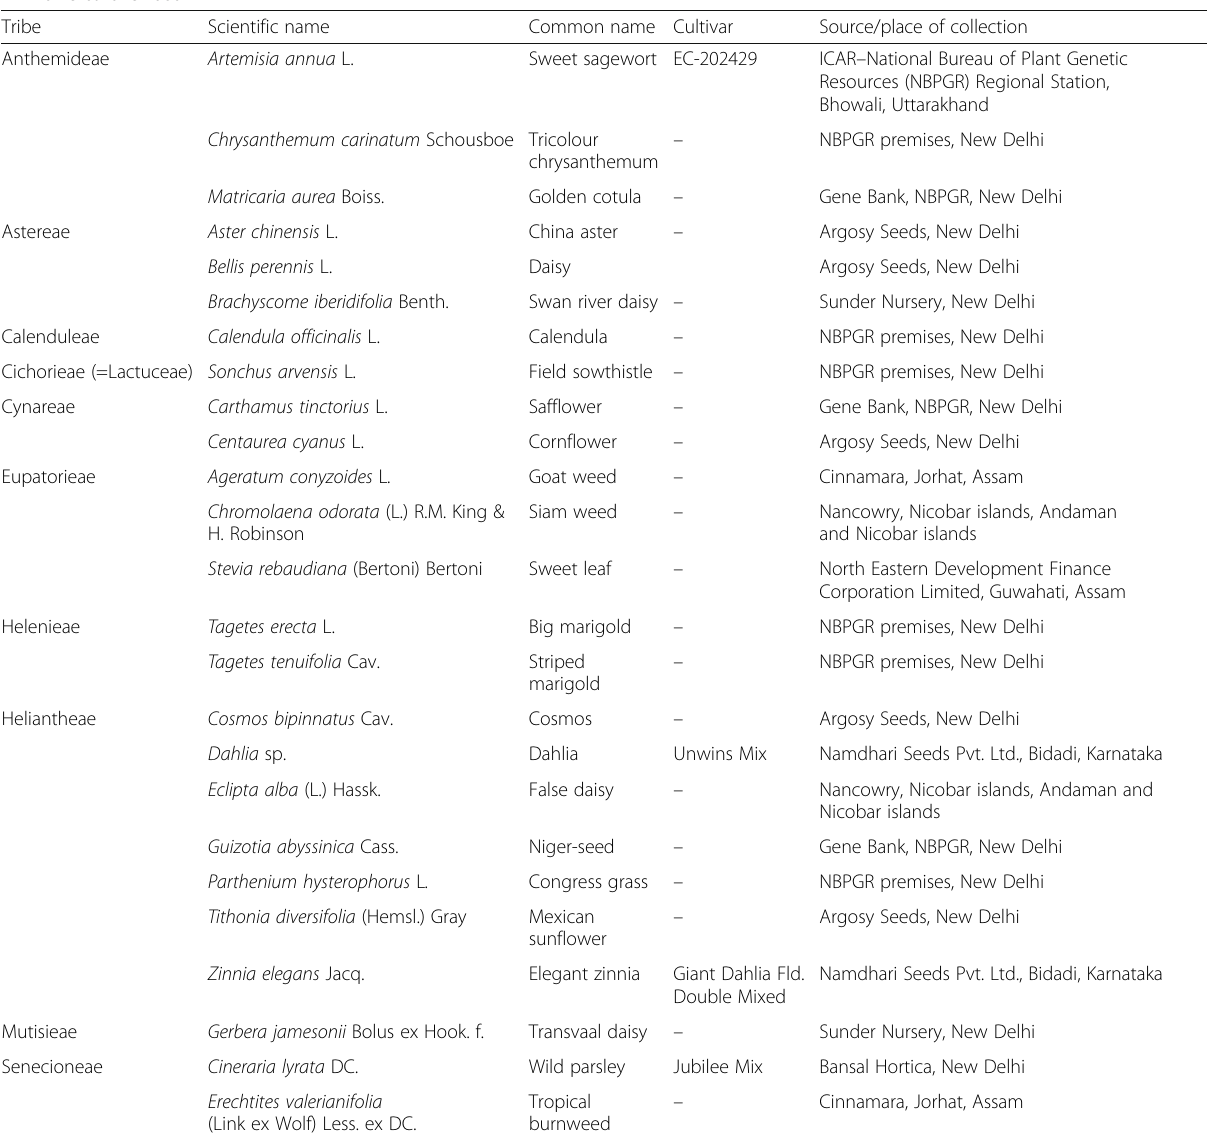
Table 2 Asteraceae other than sunflower ( Helianthus annuus ) tested against Puccinia spegazzinii (Peruvian pathotype) and found immune to the